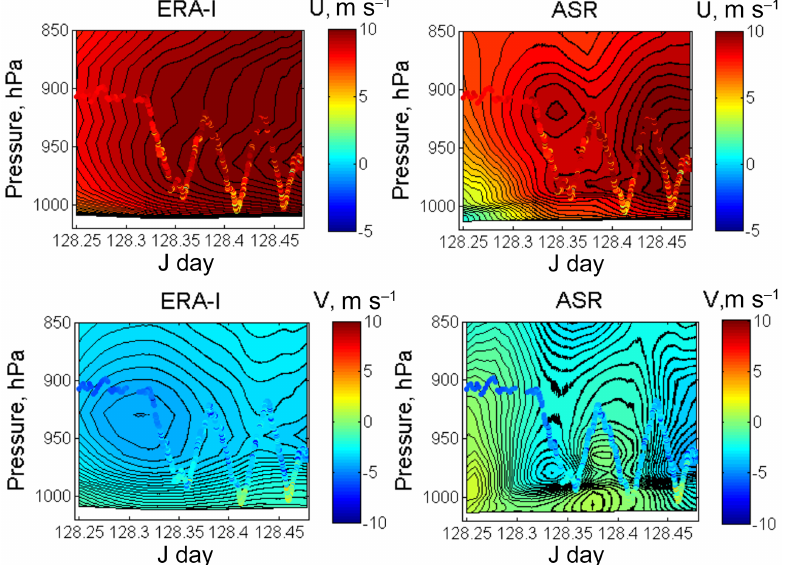
Figure 6. U and V winds observed during the CMET flight 4 soundings (filled circles) compared to 4-D interpolated (latitude, longitude, pressure, time) model data from ERA-I and